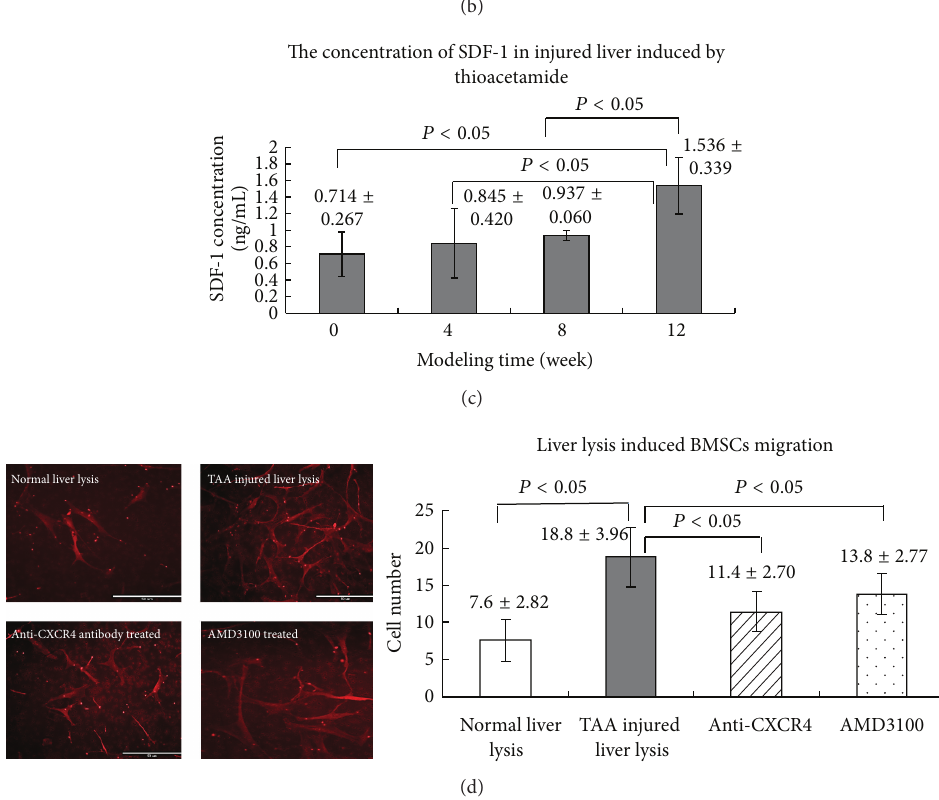
Figure 3: Injured liver lysates induce BMSCs migration in vitro . (a) Changes of serum ALT and AST level after TAA injection; (b) HE stained liver tissue sections after TAA injection; (c) the concentrations of SDF-1 of liver lysates detected by ELISA at different time point of TAA induced liver injury; (d) the migrated cells induced by normal liver lysates and TAA injured liver lysates. More cell migration was induced by TAA injured liver lysates which could be partially blocked by AMD3100 (24 𝜇 g/mL) or anti-CXCR4 antibody (20 𝜇 g/mL). The migrated cells were observed under fluorescence microscope and the graph indicated the number of migrated